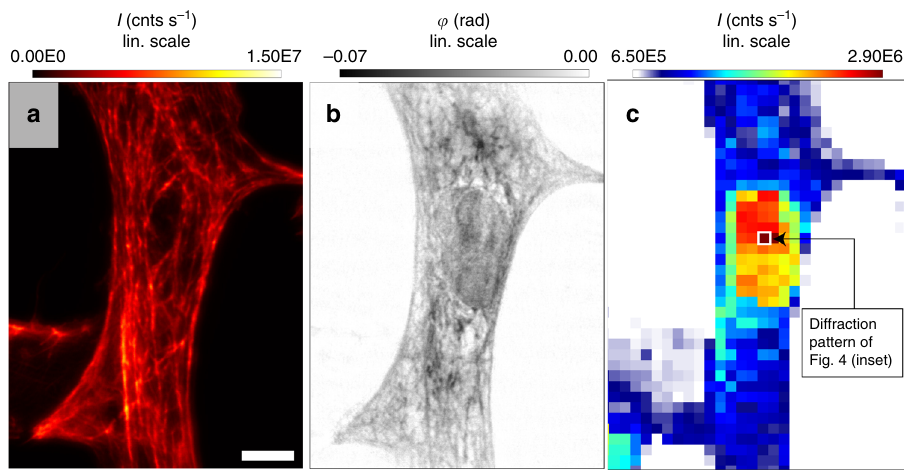
Fig. 2 Single cell dataset in all three imaging modalities. a STED micrograph of a neonatal cardiac tissue cell, centered around the nucleus. Scale bar: 5 μ m. b X-ray phase reconstruction. c X-ray dark fi eld map of the cell obtained by scanning